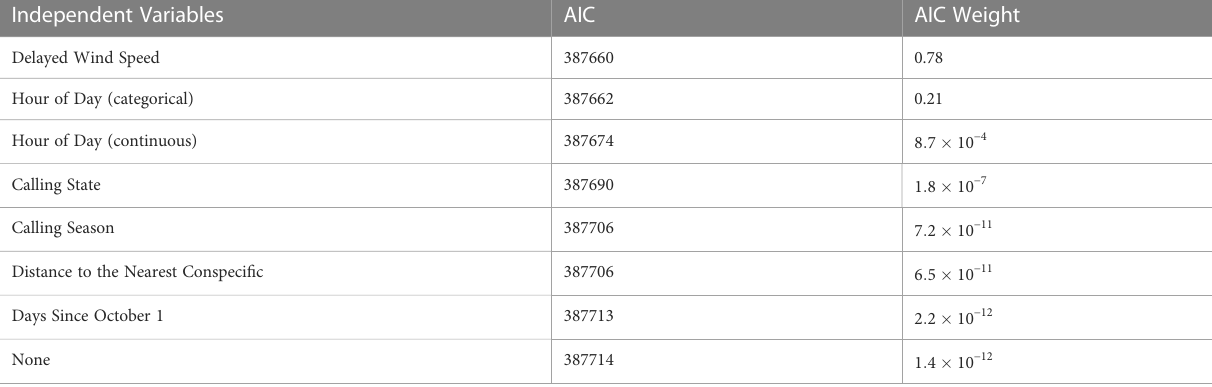
Hour of day (categorical) was grouped into four categories for night, dawn, day, and dusk. Hour of day (continuous) is modeled as a cosine function. Calling state indicates whether the focal minke whale was calling nominally or rapidly. Calling season isde fi ned as the time from October – May ofeach year when minkewhales were recorded on PMRF (2012 – 2013, 2013 – 2014, 2014